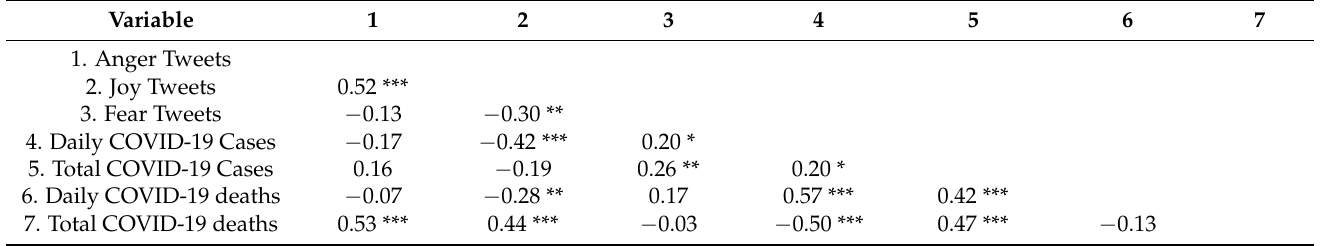
Table A8. Bari Pearson’s correlation coefficient matrix